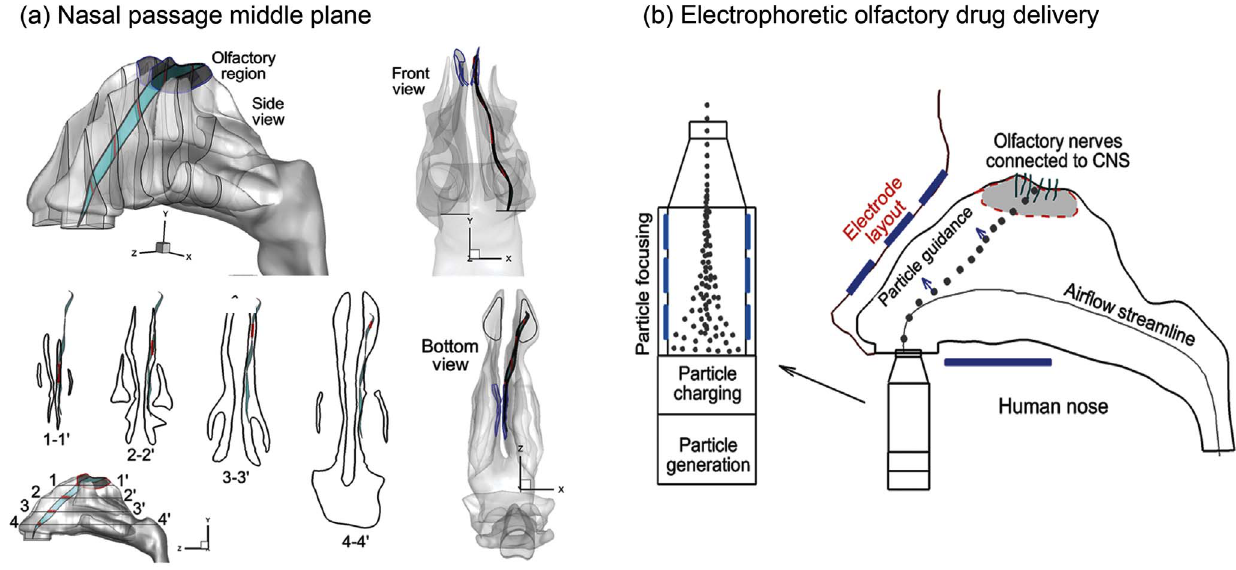
Figure 1. Nasal airway anatomy with the olfactory region (OR). Geometric complexity and narrowness of the nasal airway prevents effective intranasal drug delivery. To avoid contact loss to the wall, particles should closely follow the middle plane (a) of the nasal passage, which exhibits three-dimensional spatial features. A simple delivery system is shown in (b) which consists of components with the following four functions: (1) aerosol generation (inhaler), (2) particle charging, (3) particle focusing, and (4) particle navigation control. A more elaborate system can have supports to stabilize the device relative to the human head.